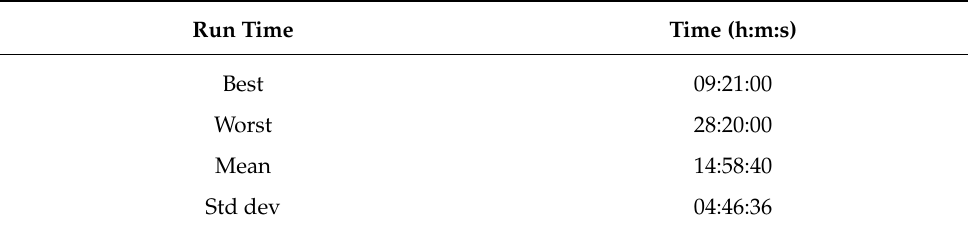
Table 10. Experiments measures: running time for Scenario Scenario